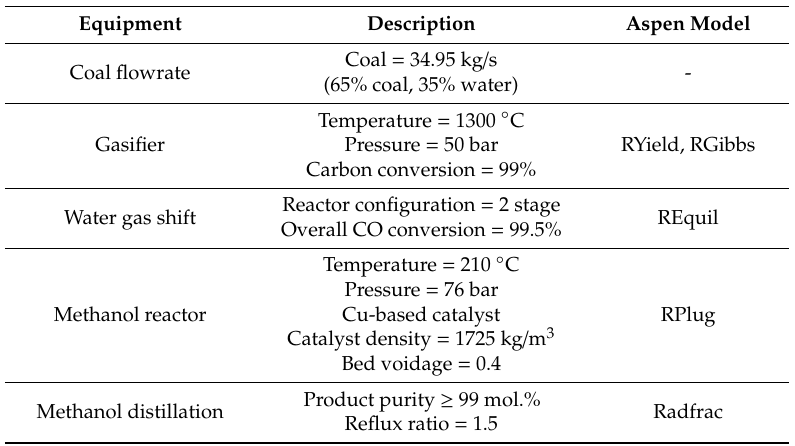
Table 2. Key specifications used in the